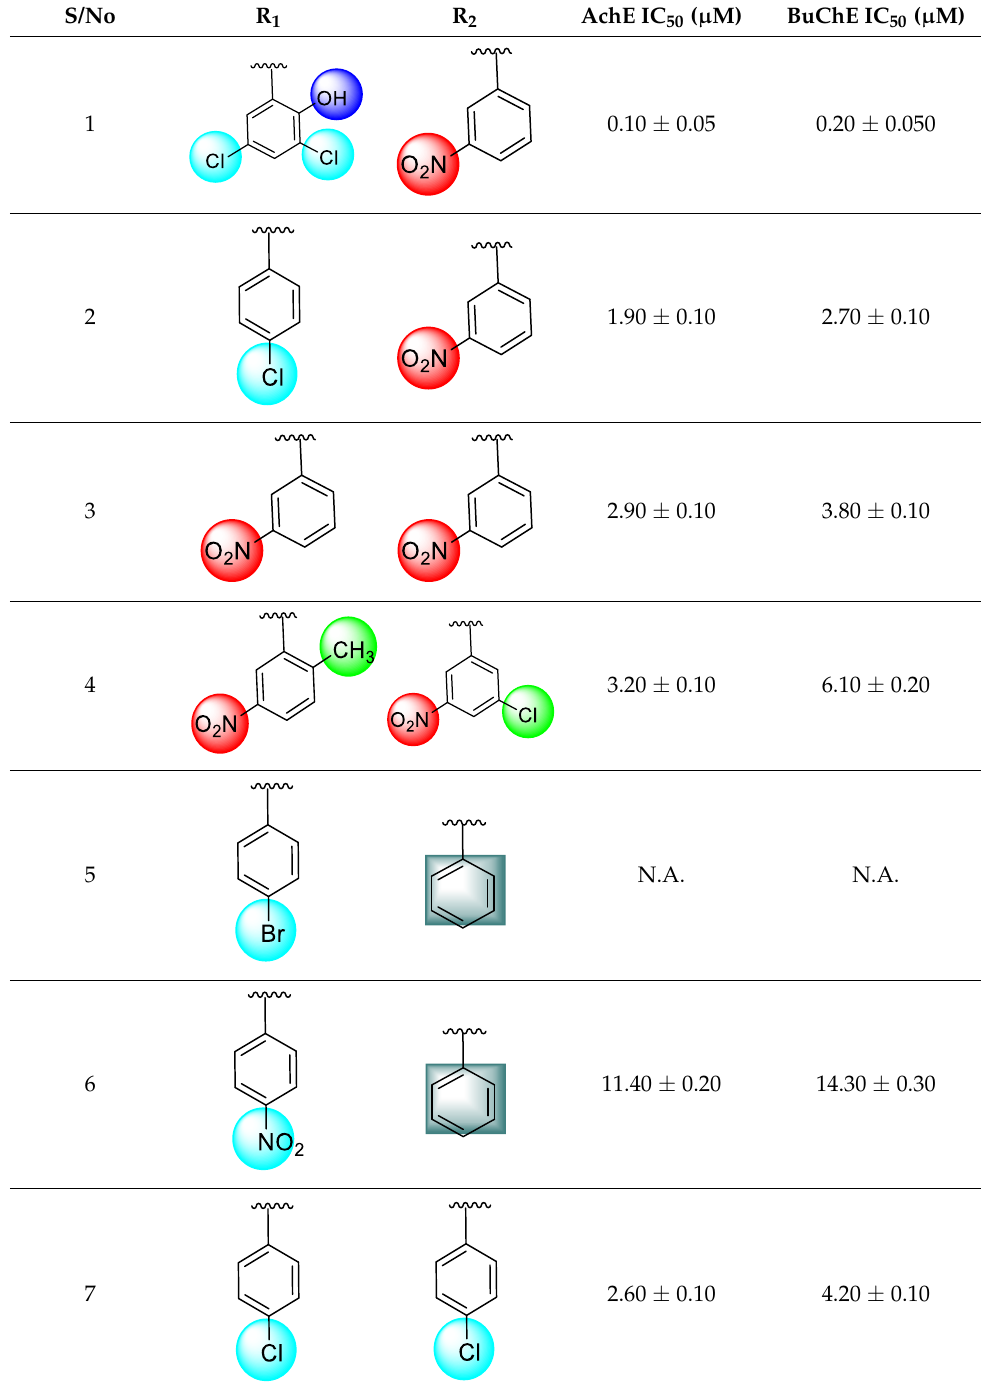
Table 1. Different substituents, acetylcholinesterase and butyrylcholinesterase activities of thiazole- bearing sulfonamide analogs.